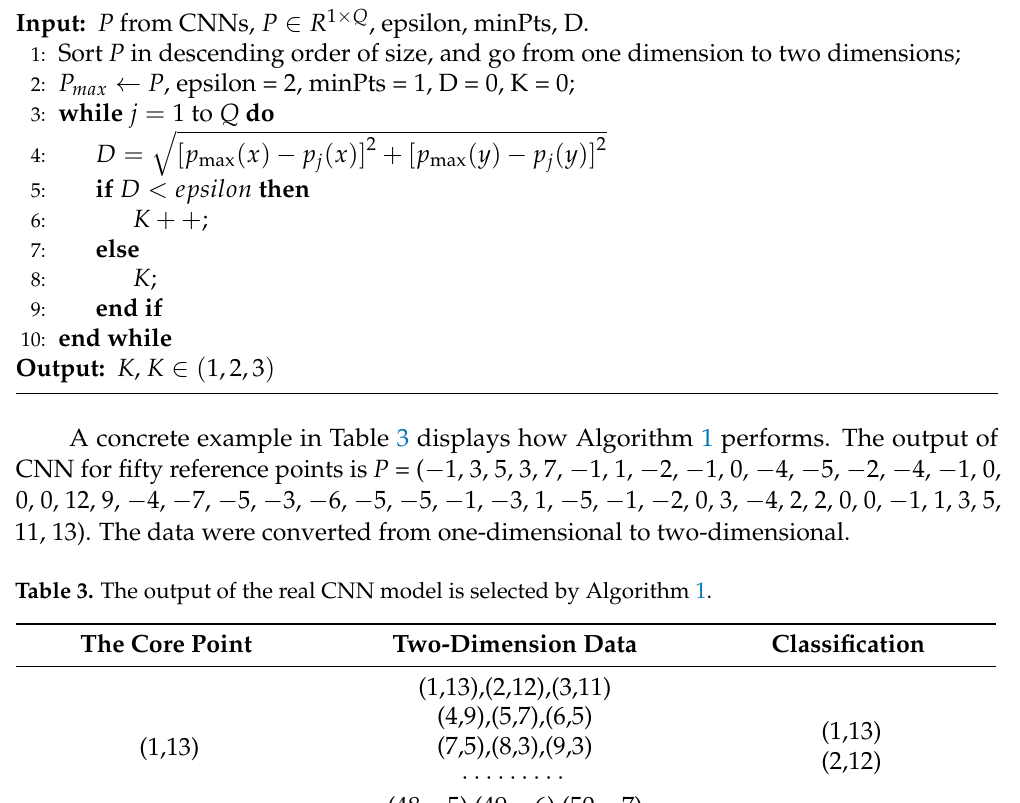
Algorithm 1 Different DBSCAN-based K value selections.